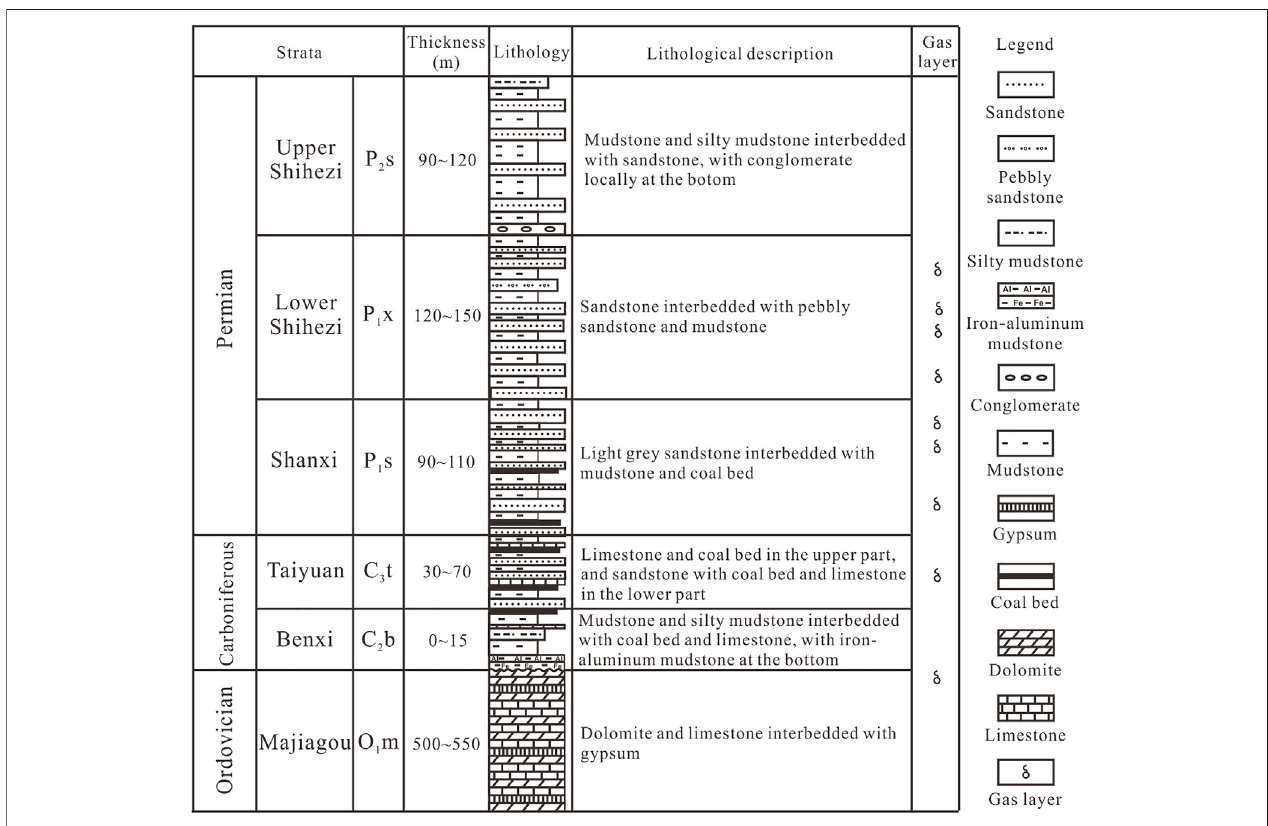
FIGURE 2 | Stratigraphic column of the Daniudi gas fi eld, Ordos